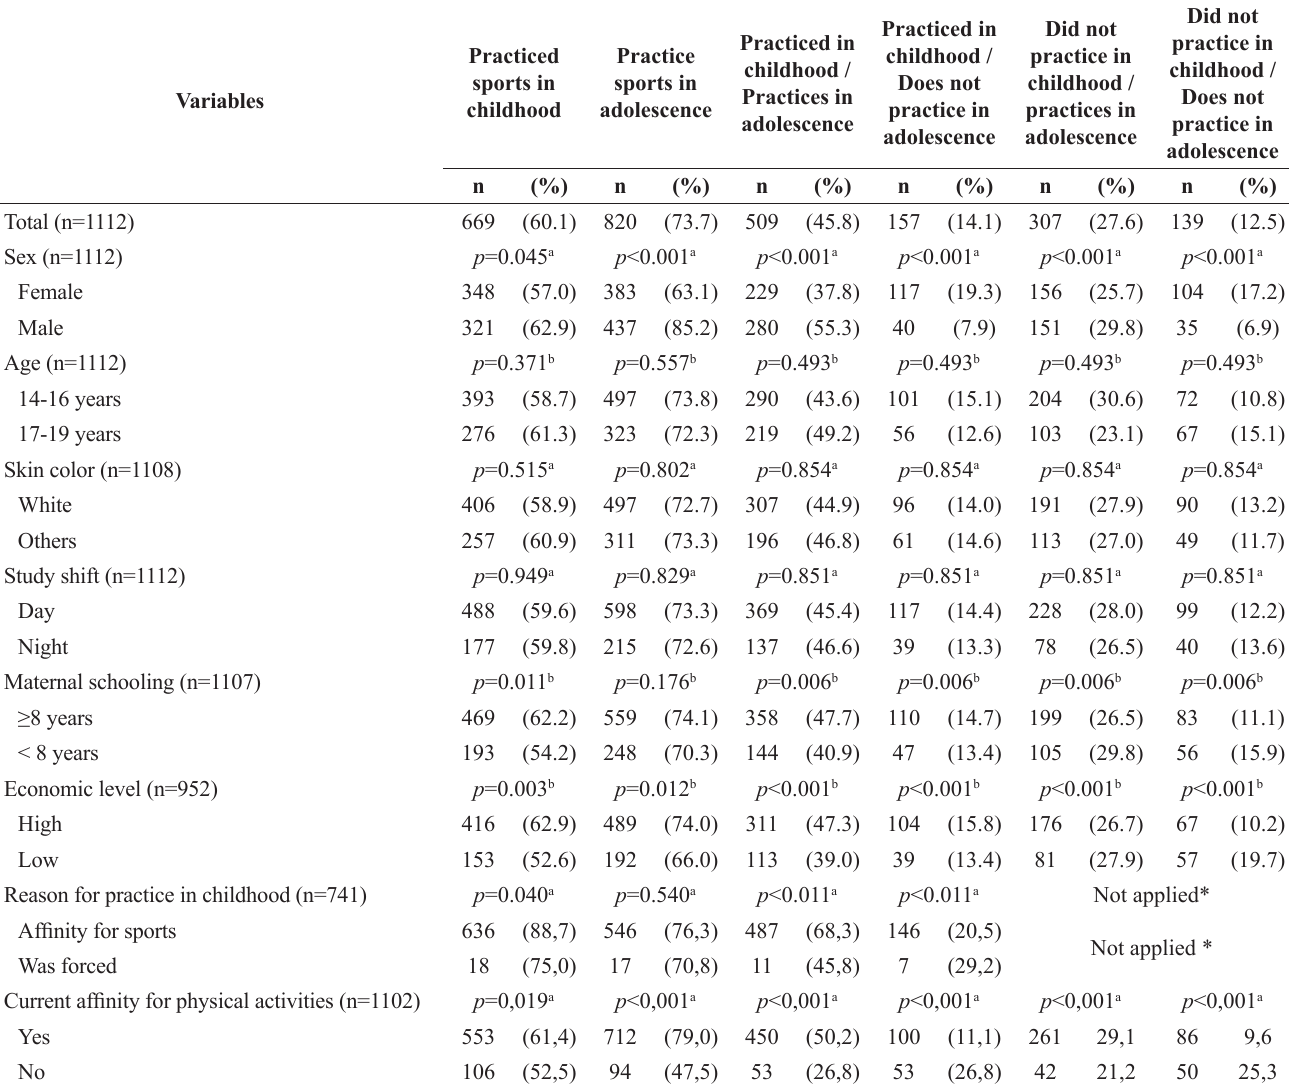
Table 1. Previous and current sports practice of adolescents according to demographic, economic variables and affinity for physical activities.